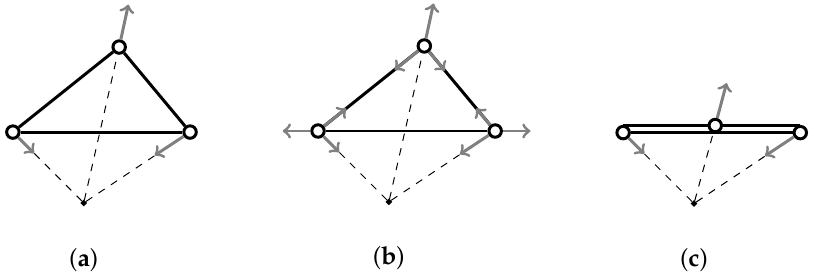
Figure 3. ( a ) An equilibrium load on a framework ( K 3 , p ) in the plane. This load can be resolved by ( K 3 , p ) as shown in ( b ). ( c ) An unresolvable equilibrium load on a degenerate triangle: tensions or compressions in the bars cannot reach an equilibrium with the load vector at any of the